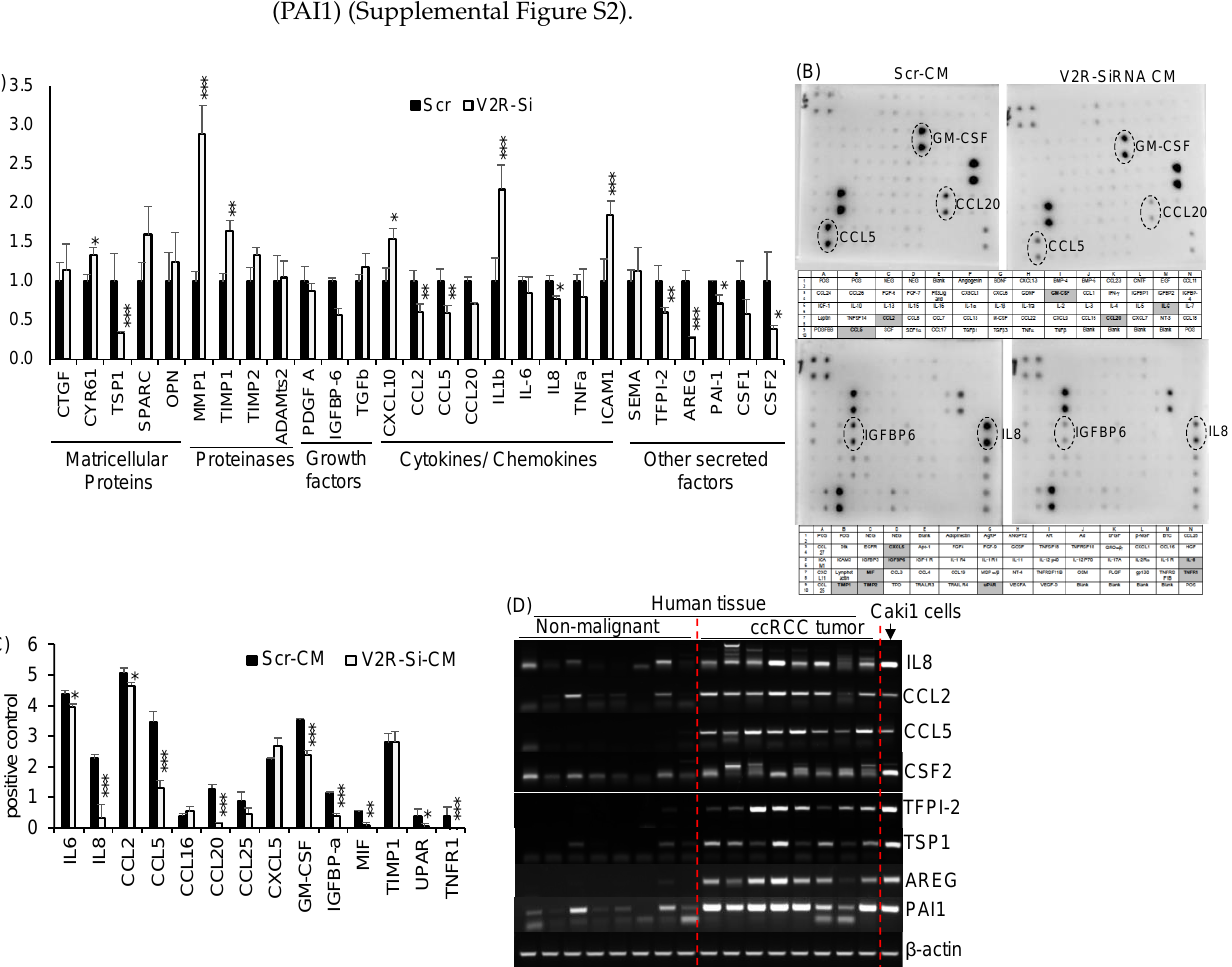
Figure 2. V2R regulates secreted factors produced by ccRCC tumor cells: ( A ) QRTPCR for mRNA levels of secreted factors relative to GAPDH in Caki1 cells transfected with Scr or V2R-SiRNA for 48 h. n = 4. ( B ) Antibody arrays show proteins in Scr-CM or V2R-SiRNA-CM from Caki1 cells. Each antibody is spotted in duplicate vertically. ( C ) Quantitation of band density relative to positive control based on antibody array shown in B. ( D ) mRNA measured by RTPCR. Each band represents one human ccRCC tumor or non-malignant kidney tissue sample. * p < 0.05, ** p < 0.01, *** p < 0.001 vs. Scr by t -test.